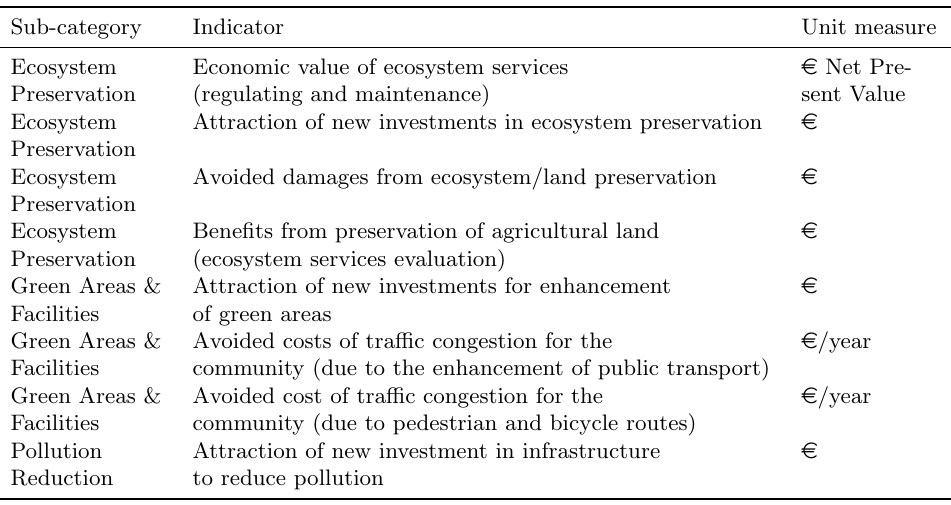
Table 3: Environment and natural capital